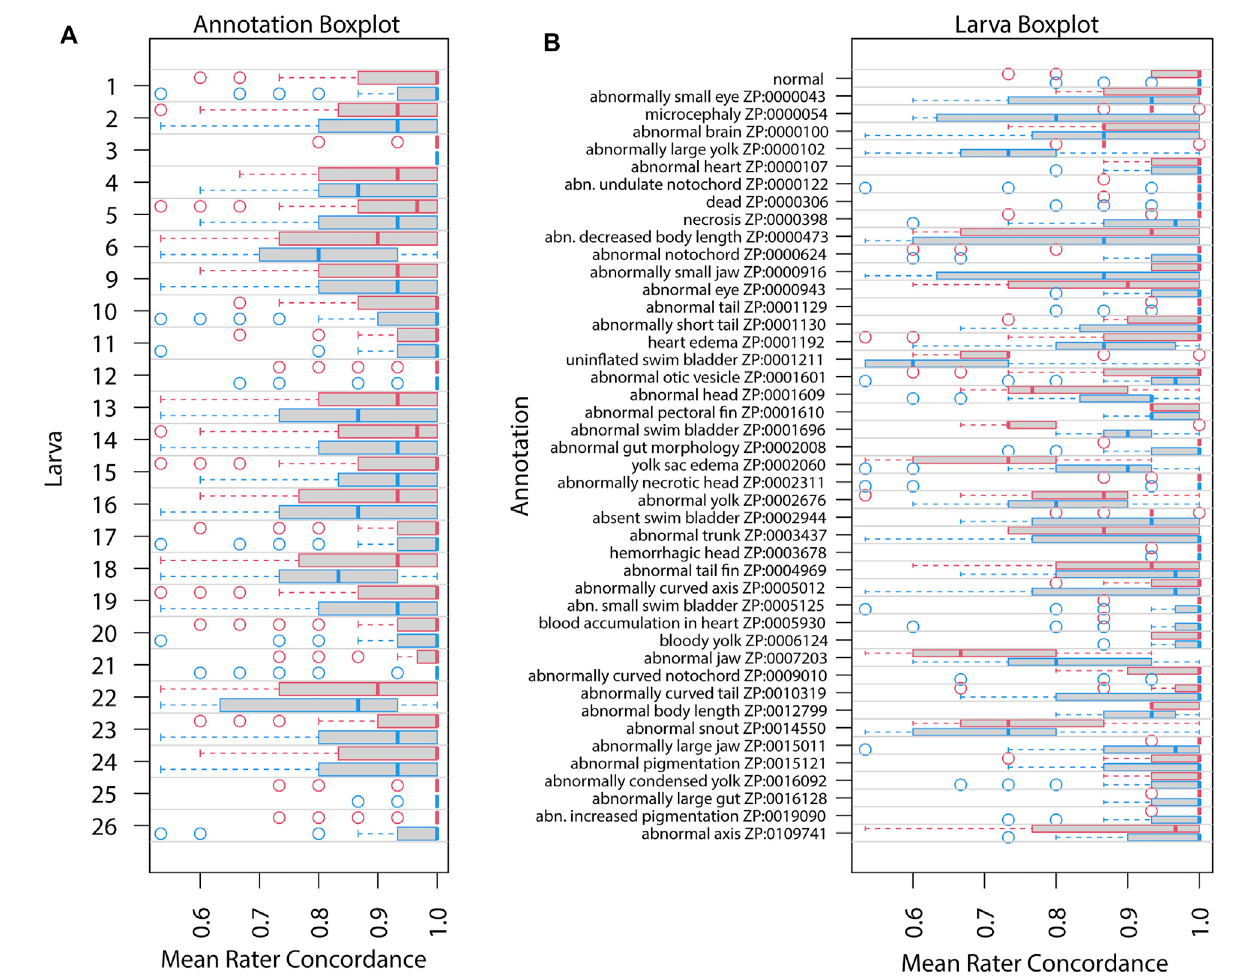
FIGURE 4 | Mean rater concordance using granular phenotype terms. These boxplots show the mean concordance ( x axis and red or blue bar in shaded box) of theratersbylarva (A) orbyannotation (B) withinterquartilerangeindicatedbyshadedarea( fi rsttothirdquantiles).DatafromSurvey1areinredandfromSurvey2arein blue.Thedashedwhiskersdenotethedatathatarewithin1.5timestheinterquartilerange,withcirclesannotatingdataoutsidethatrange.Pleasenotethatlarvae7and8 did not exist. No data were discarded.